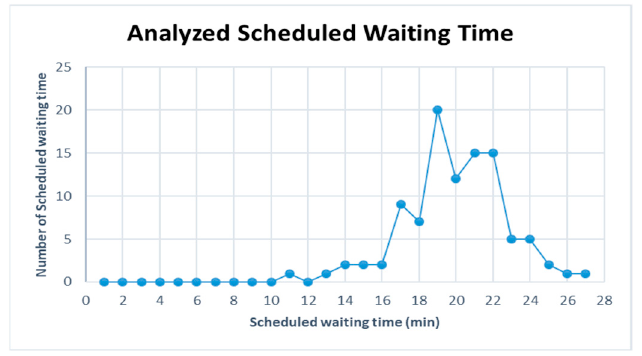
Figure 13. Analyzed Scheduled Waiting Time for Case 3.